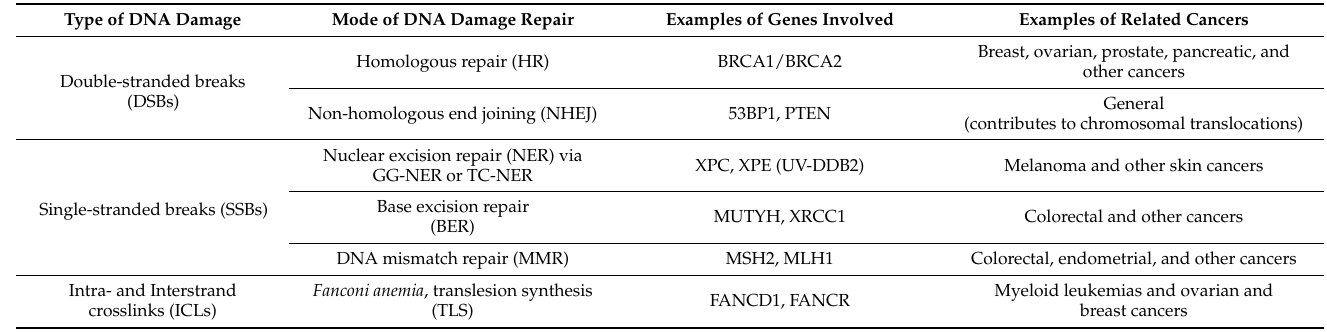
Table 1. Summary of Types of DNA damage, Modes of repair, Genes involved and related